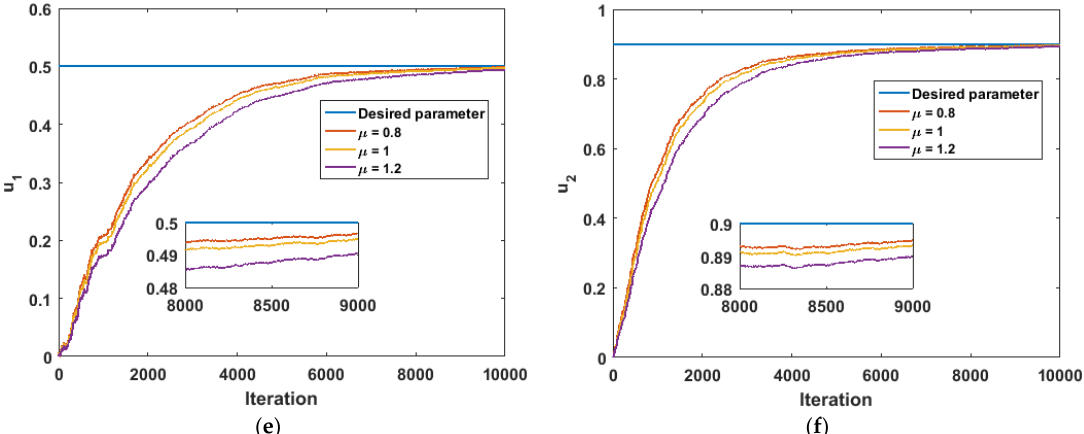
w w ; ( b ) Estimate of 2 ; ( c )